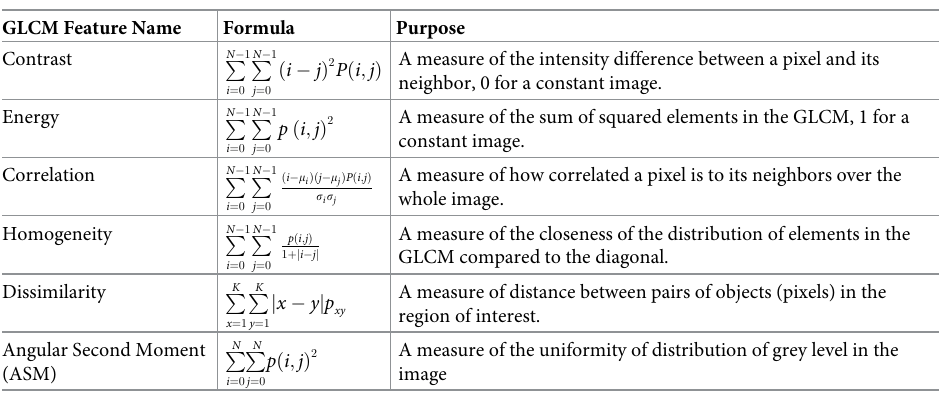
Table 1. GLCM textural features used.